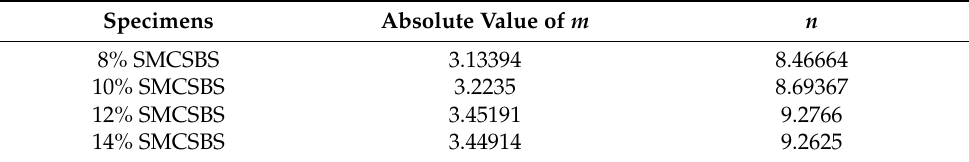
Table 6. The Saal model parameters fitted with different